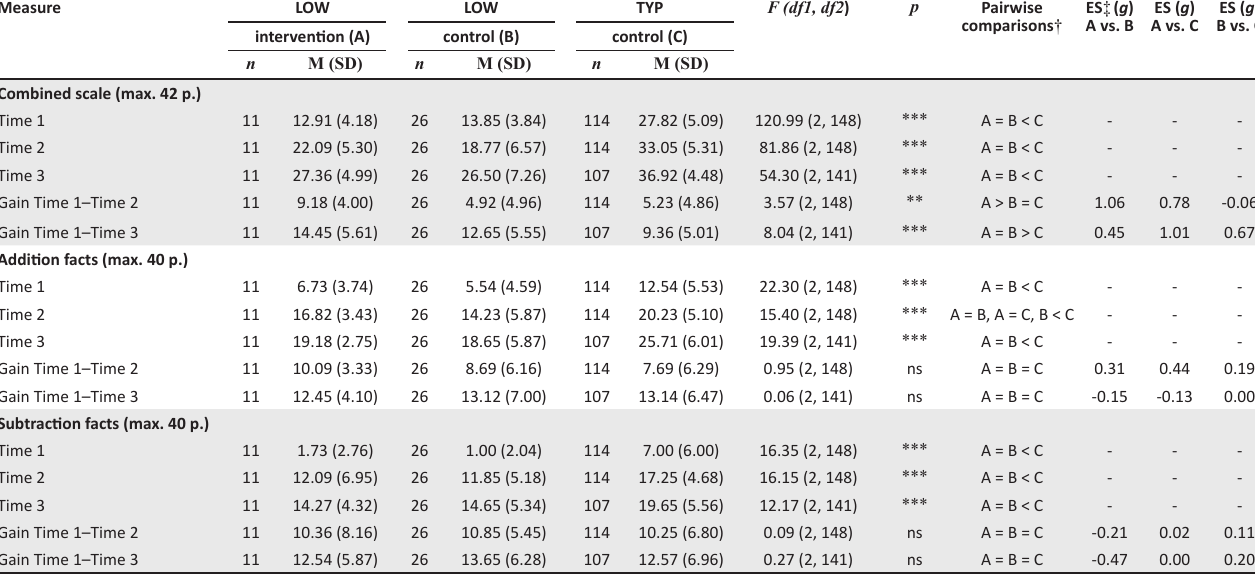
TABLE 2: Means, standard deviations and effect sizes for the mathematics scales at Time 1, 2 and 3 by group. Measure LOW